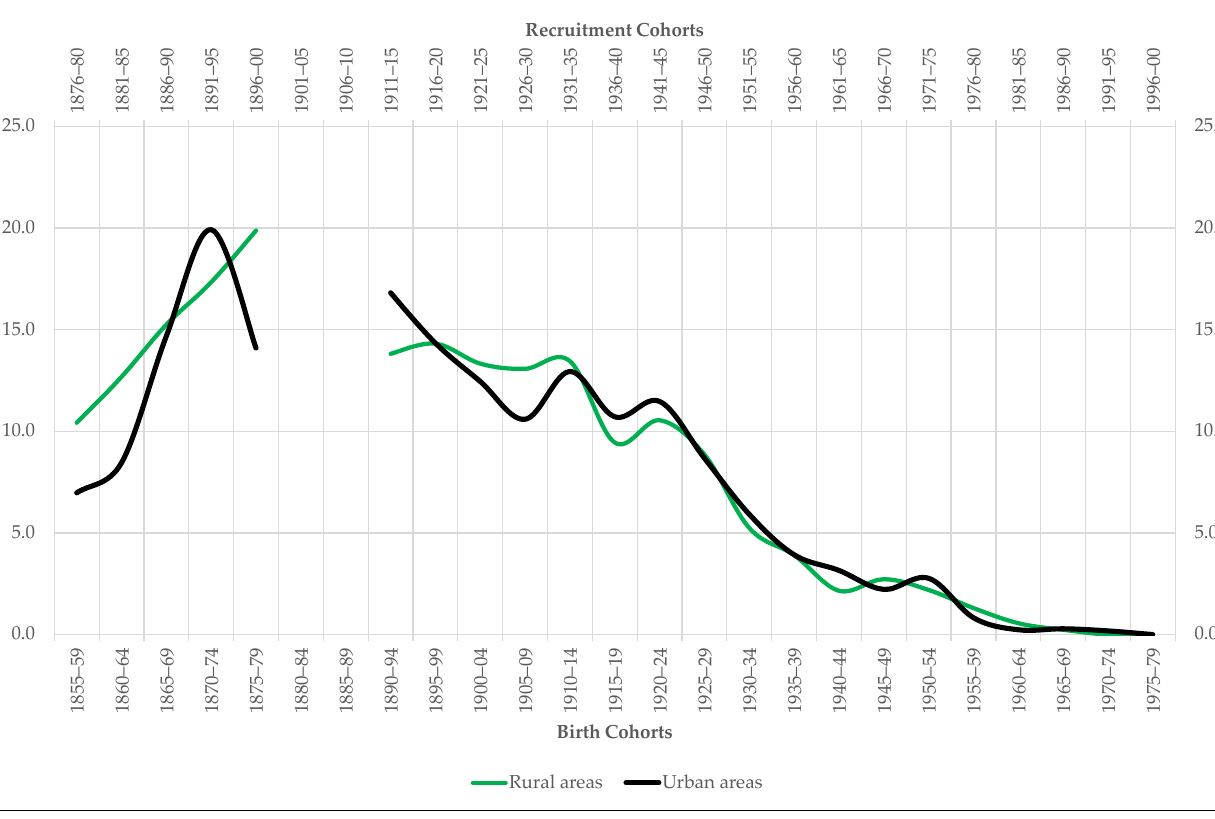
Figure 9. Proportion of recruits included in the sample Extremadura who were excluded from the military service for being short or suffering from insufficient organic development (percentage of total recruits presented for conscription).